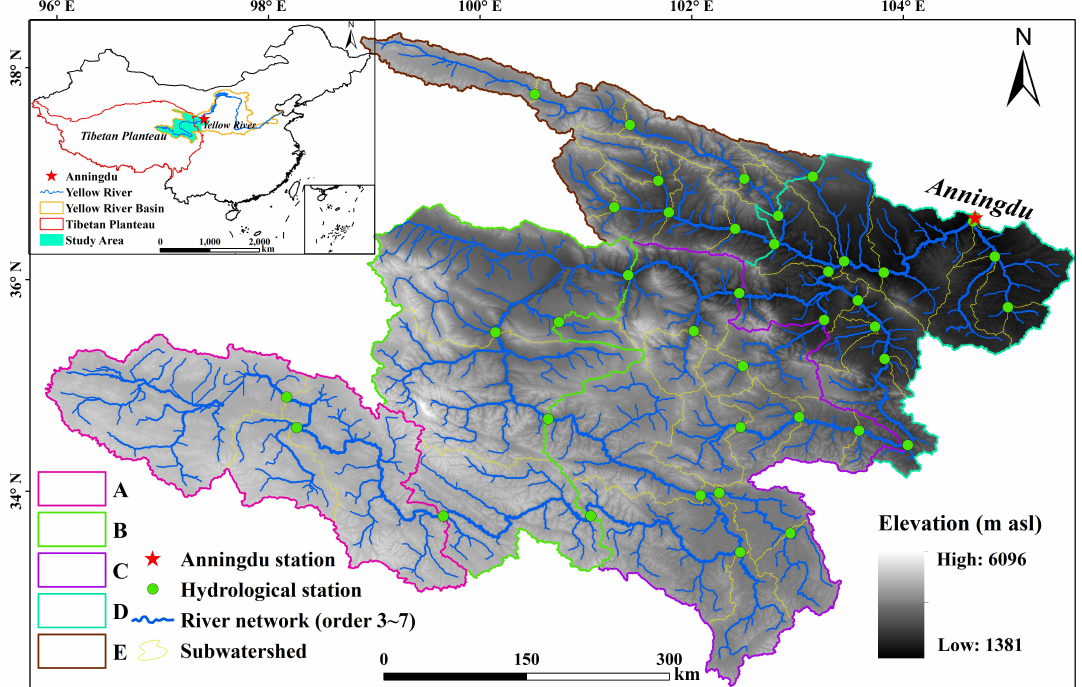
Figure 1. Study area in the Upper Yellow River. Sub-regions marked as A , B , C , D , and E . Hydrological stations marked with red pentagrams. Blue line marks the Horton–Strahler river network of orders 3–7 extracted from the SRTM 90 m DEM using the Drainage network extraction tool. Yellow subwatersheds are sub-catchments generated using Arc Hydro Tools according to the coordinates of the hydrological stations. Elevation is from the SRTM 90 m